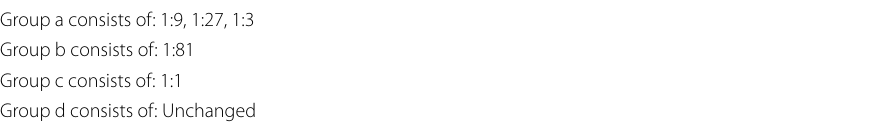
Table 20 HSD test groupings after ANOVA of AUC for the RUS factor